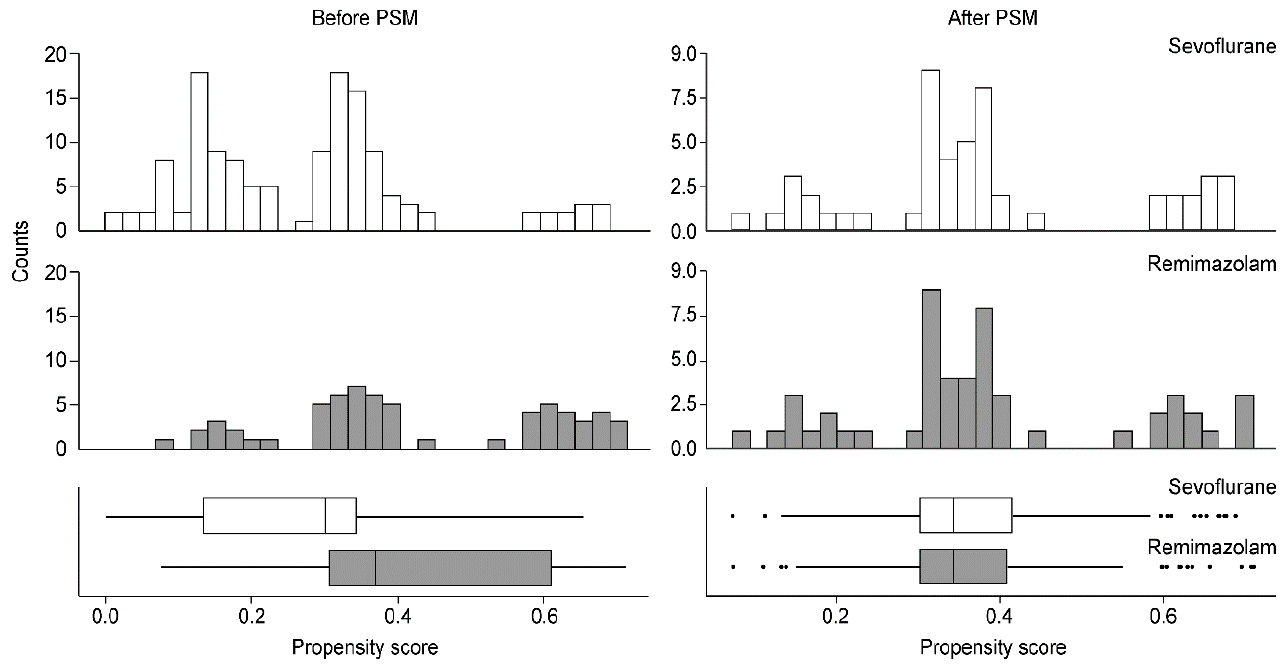
Figure 2. Distribution of propensity scores before and after matching. PSM, propensity score matching. Table 2. Intraoperative and recovery room variables before and after propensity score